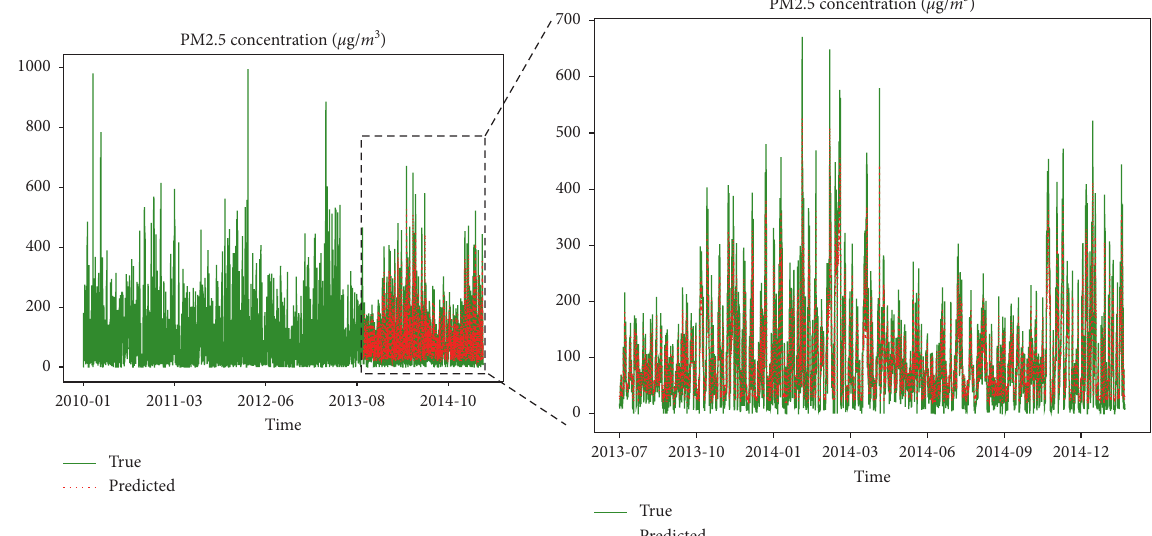
Figure 8: PM2.5 concentration prediction without TL from